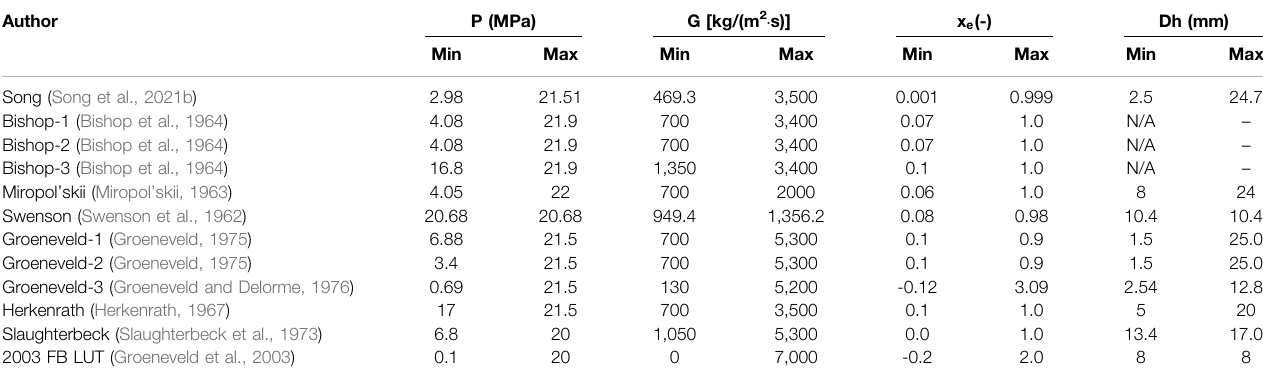
TABLE 7 | Validity range of post-CHF heat transfer models.